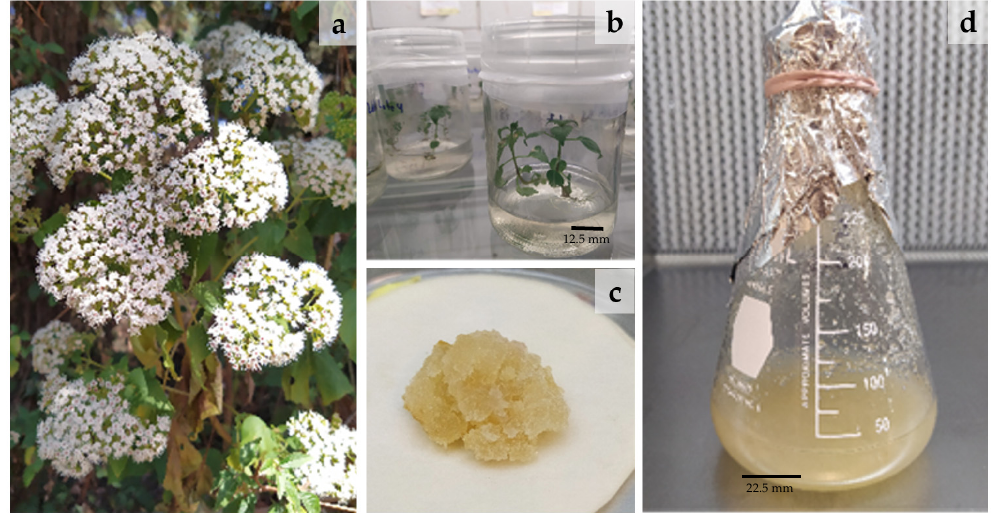
Figure 1. Ageratina pichichensis : ( a ) Wild plants (WP) collected at the natural site, ( b ) germinated plant in vitro (IP), ( c ) callus cell culture (CC), and ( d ) cell suspension culture (CSC). The treatments T3 and T4 were transferred to Murashige and Skoog (MS) liquid me-